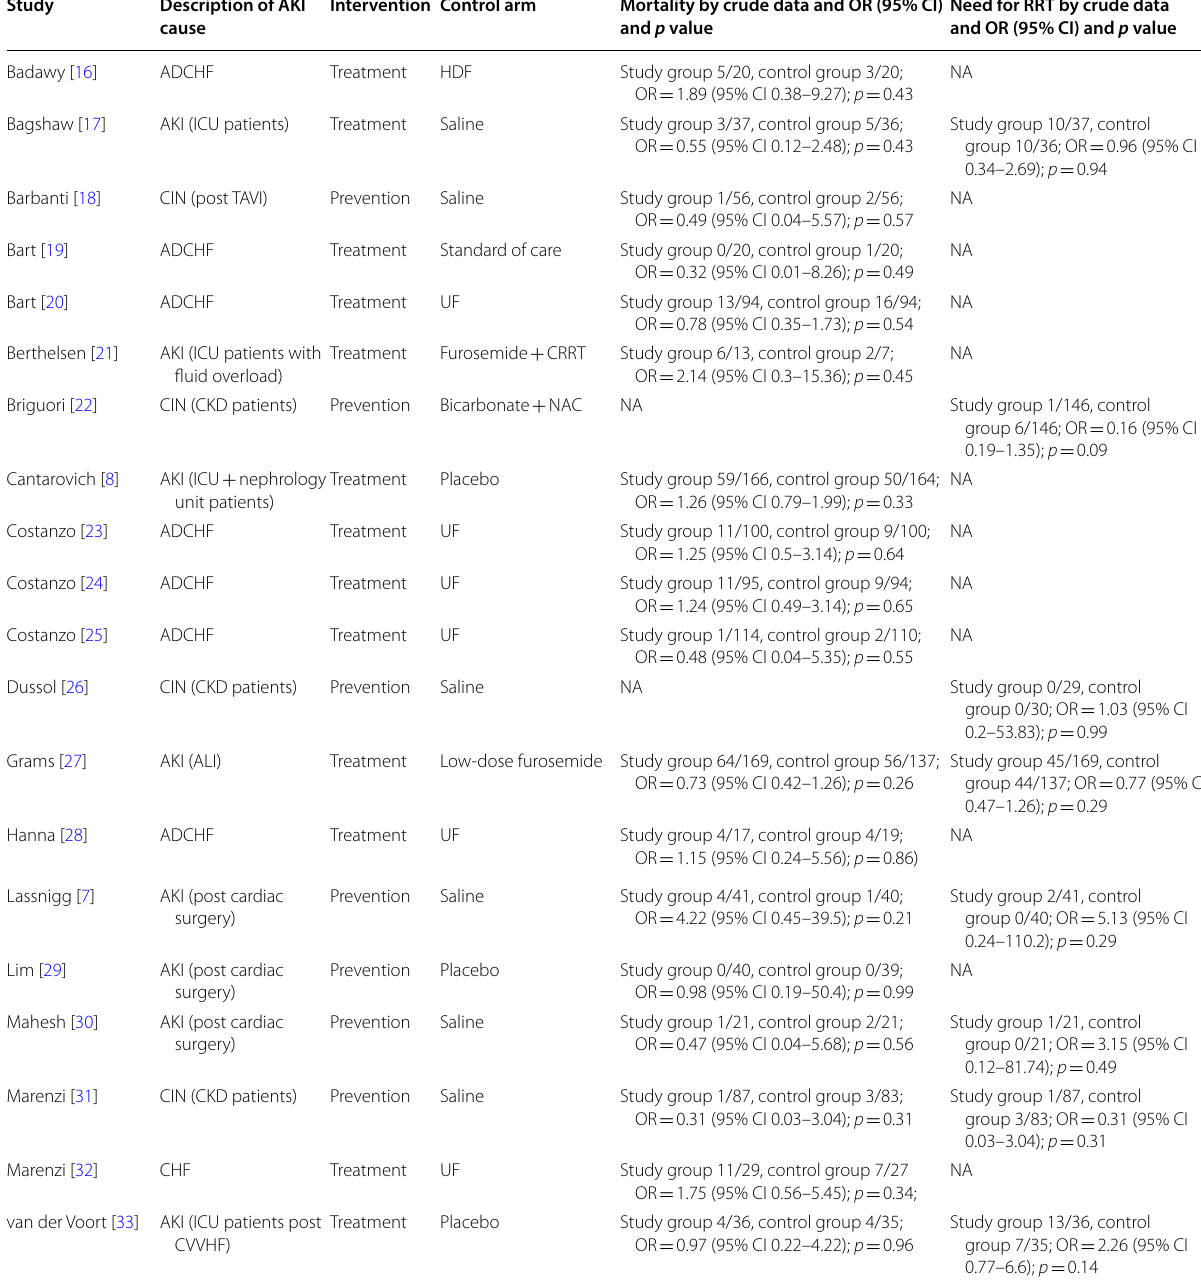
Table 2 Systematic review of studies on furosemide and the outcome Study Description of AKI Intervention Control arm Mortality by crude data and OR (95% CI) cause and p value